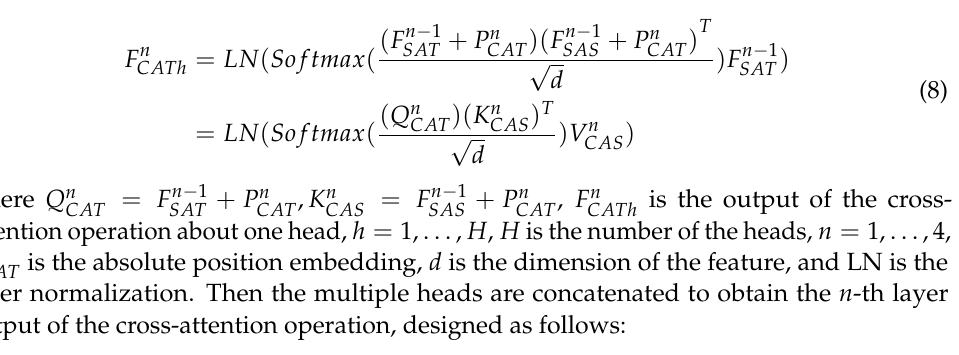
Output F nCAT (HCA)Feature (b) Hyperspectral Multi-Head Cross-Attention Figure 2. The detailed demonstrated ion of transformer-based context fusion. ( a ) The self-attention of the template branch in the n -th layer is displayed on the left, and that of the search region branch is on the right. ( b ) The cross-attention of the template branch in the n -th layer is displayed on the left, and the final cross-attention layer is on the